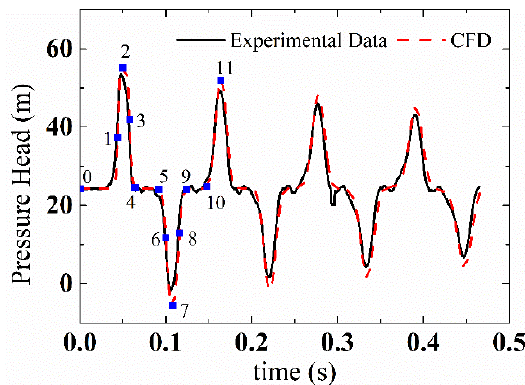
Figure 9. Experimental data and numerical simulation results of pressure head fluctuation at S1 monitoring point.